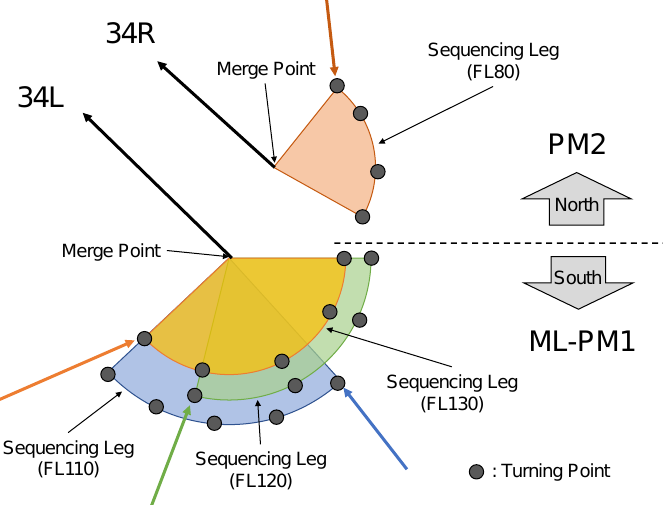
Figure 6. Schematic diagram of the configuration of the point-merge (PM) system connected to 34L (multi-level point merge 1: ML-PM1) and 34R (point merge 2: PM2) in Tokyo Approach Control Area (TACA) with northerly wind